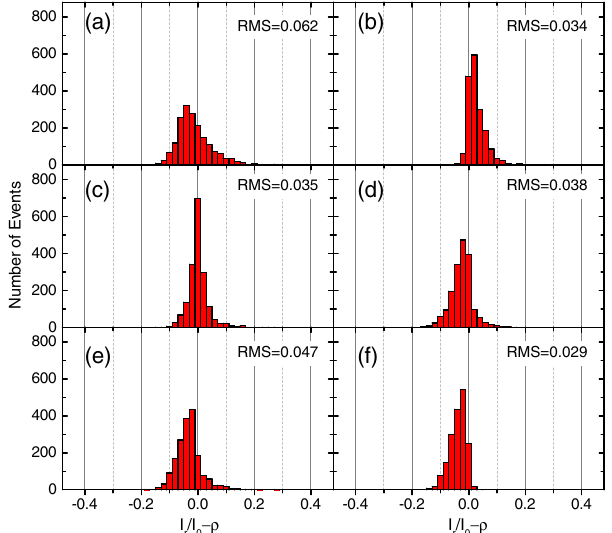
FIG. 7. Histograms of the difference in the normalized intensity evaluated with the analytical formula and numerical